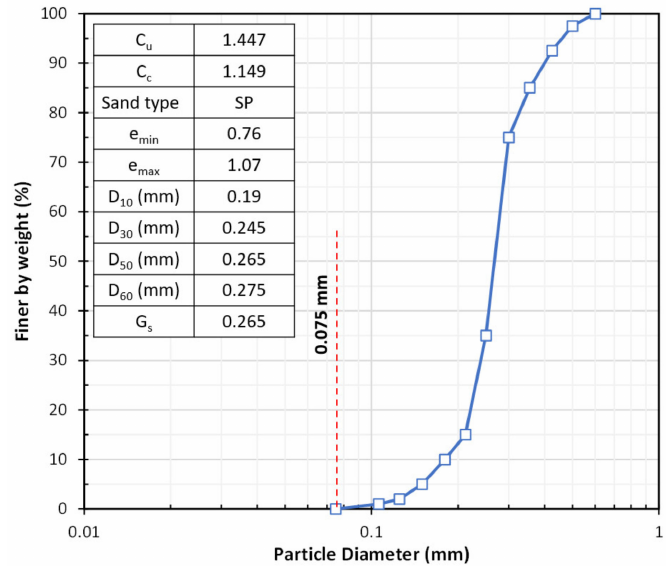
Figure 1. Grain-size distribution curve of the test